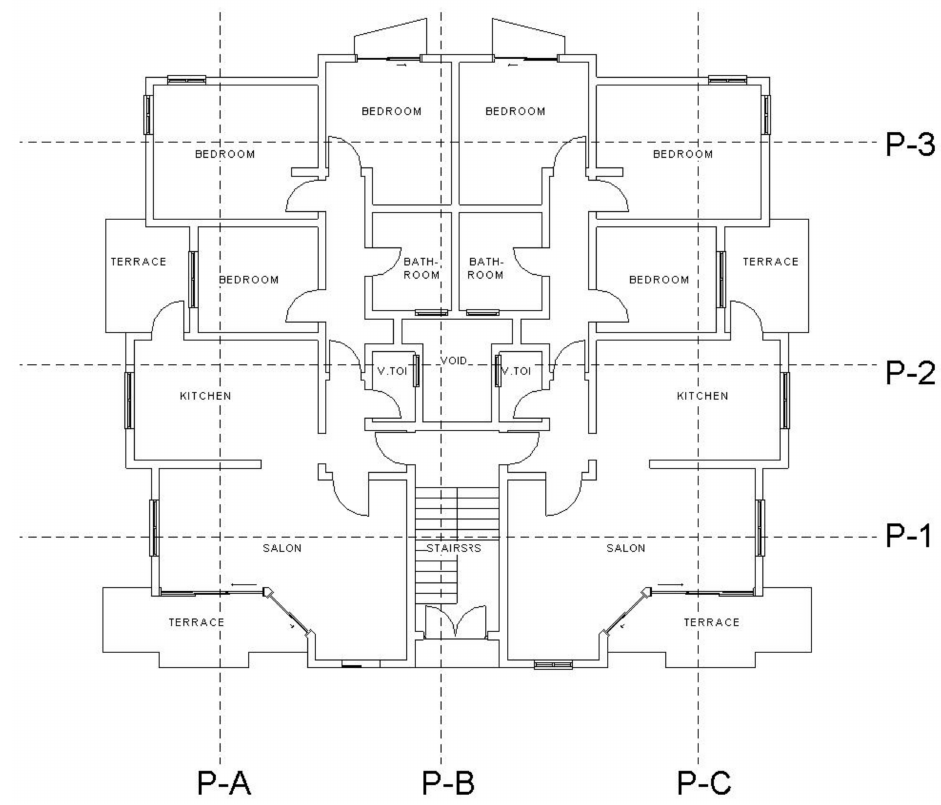
Figure 7. The ground floor plan of the simulated